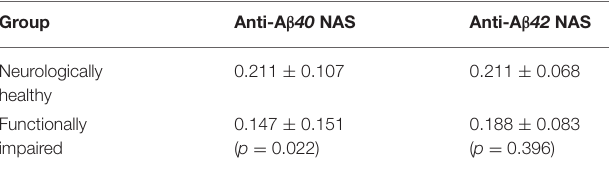
TABLE 3 | Comparison of net adsorbed signal (NAS) (mean ± SD) of anti-A β 40 and A β 42 antibodies between the groups after applying the > 3 SD cut-off. Group Anti-A β 40 NAS Neurologically